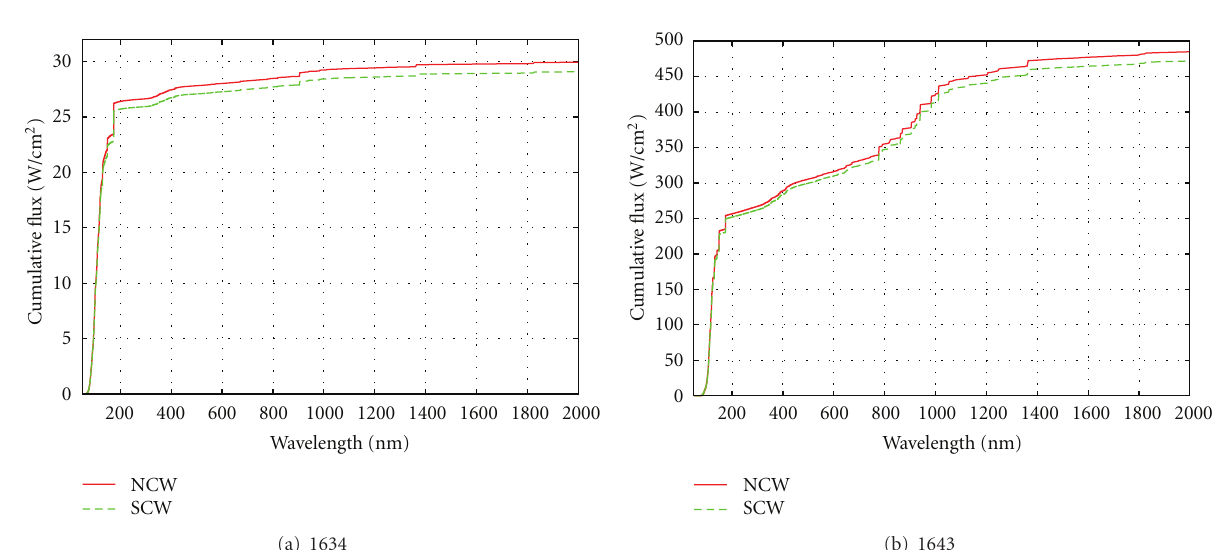
Figure 8: Influence of the super catalytic wall